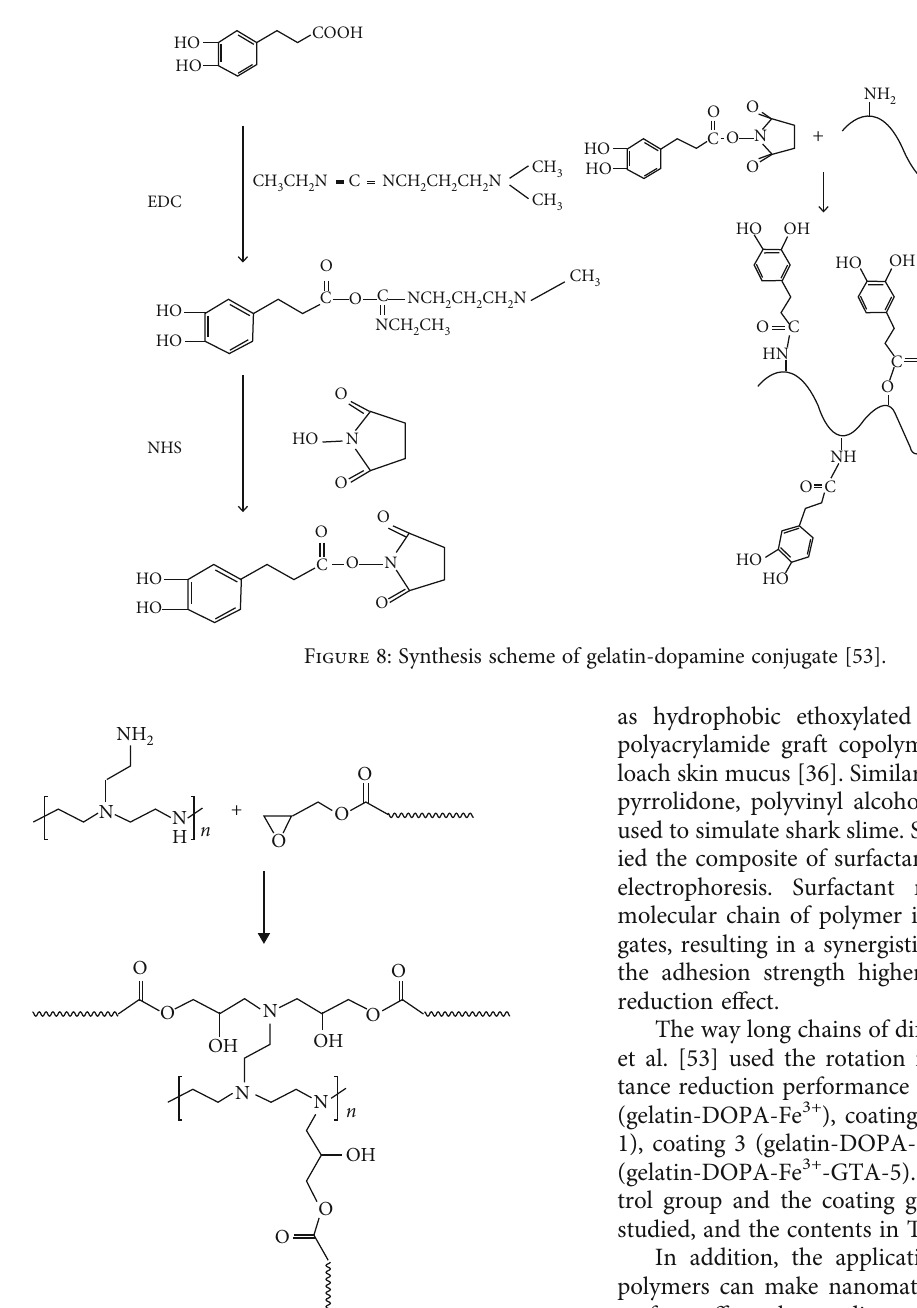
Figure 9: Crosslinking reaction equation between microspheres and acrylic polymer coating